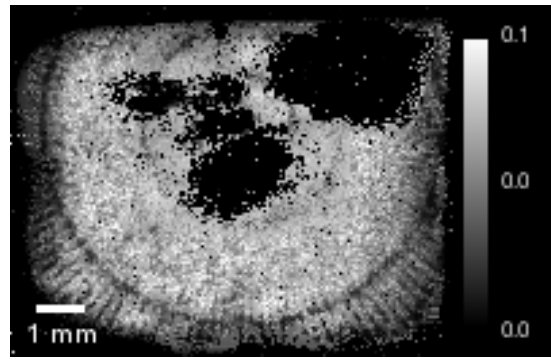
Figure 11. Neutron image of Seimens star on PSI resolution test mask.